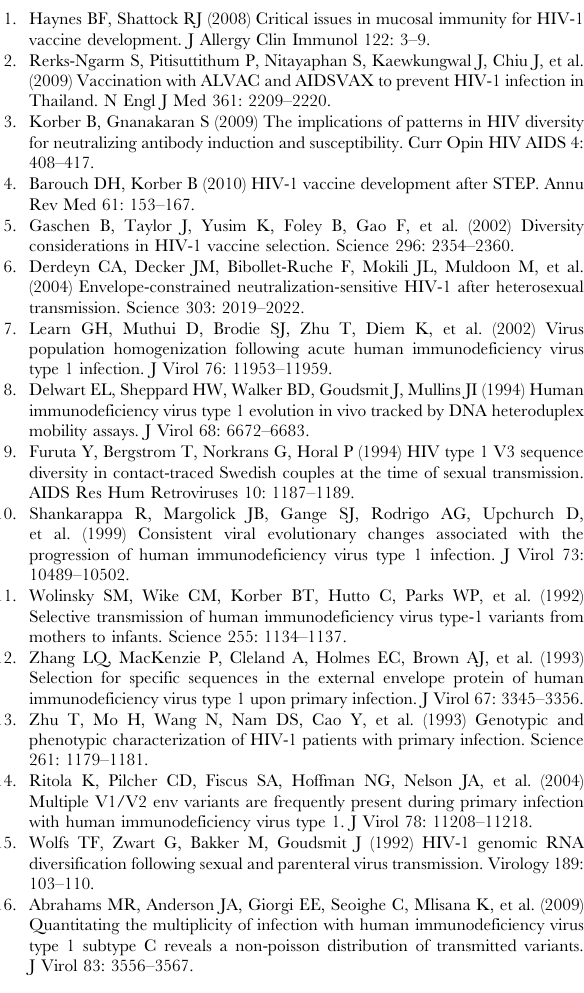
Table S8 Distributions of Amino Acid Sets for Cluster 437: Sites 207, 326, 327, 422, 436, 437, 439. Sphere-sets (sets/clusters of amino acid sites within a sphere centered on a surface residue with diameter selected to fit a typical conforma- tional antibody epitope) potentially containing antibody epitopes were evaluated using a generalized linear model fit by generalized estimating equations, to assess a different distribution of amino acid patterns in the acute/early group versus the chronic group, relative to the reference set (the consensus among acute/early sequences). Cluster 437 (comprised of sites 207, 326, 327, 422, 436, 437, 439) had q-value , 0.001 and Hom-Bonferroni adjusted p-value , 0.001 for the Holdout data, and is noteworthy because the q-value and adjusted p-value are small, and because it includes CD4-induced epitope sites originally described in Wyatt et al. (1998). The table shows the distribution of amino acid sets in cluster 437 for the Original data and for the Holdout data. For the Holdout data several patterns of mutation away from the